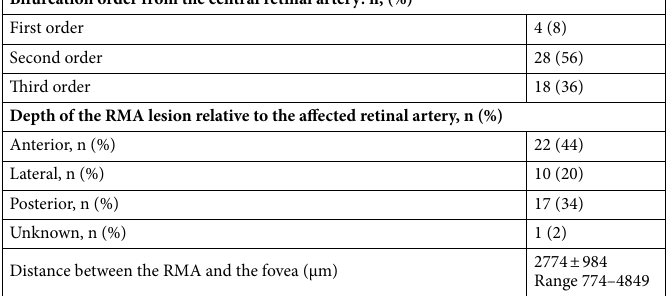
Bifurcation order from the central retinal artery: n, (%)